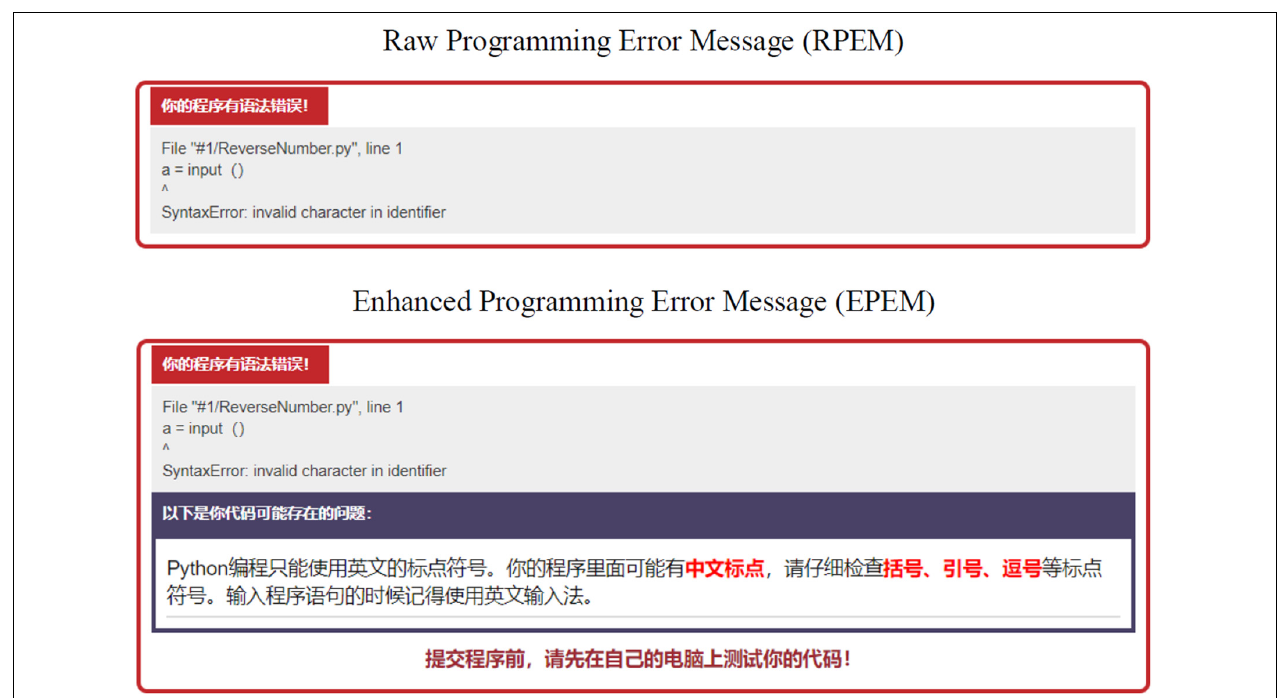
FIGURE 1 | Screen Shots of the RPEM and EPEM for “invalid character in identifier”.